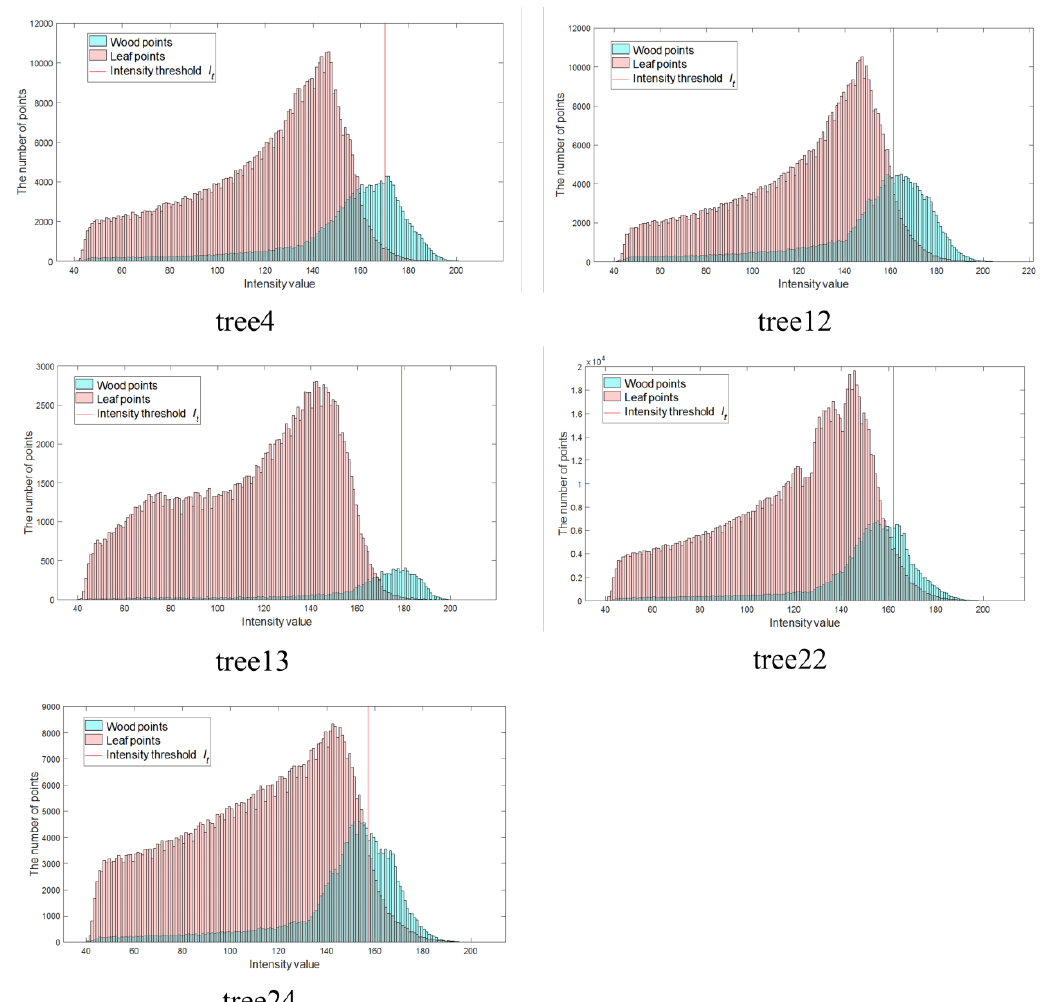
Figure 14. Display of intensity distributions for manual separation results of five trees and their adaptive intensity thresholds. Cyan areas and pink areas represent the intensity histograms of the sampled wood and leaf points, respectively. The red line represents the selected adaptive intensity threshold.